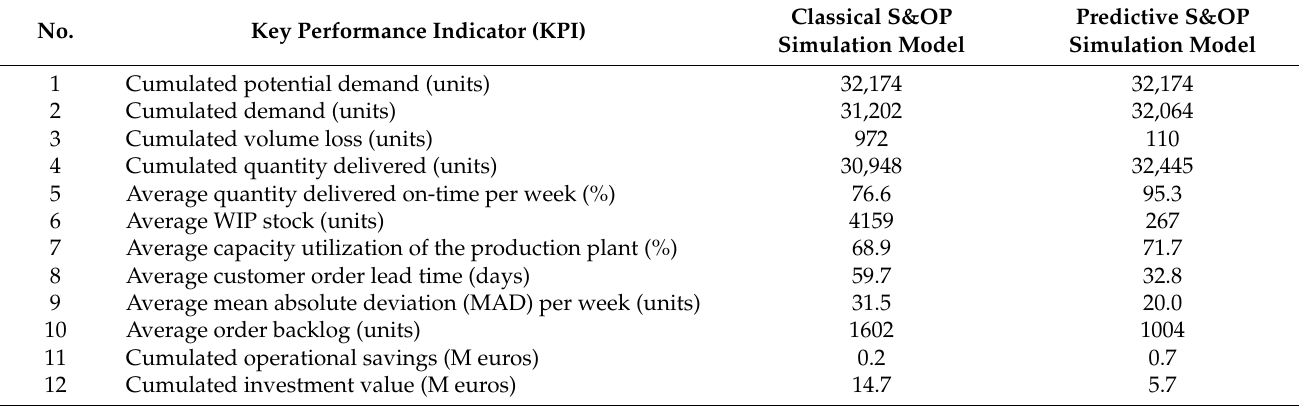
Table 9. Simulation results for demand scenario 2, the feasible